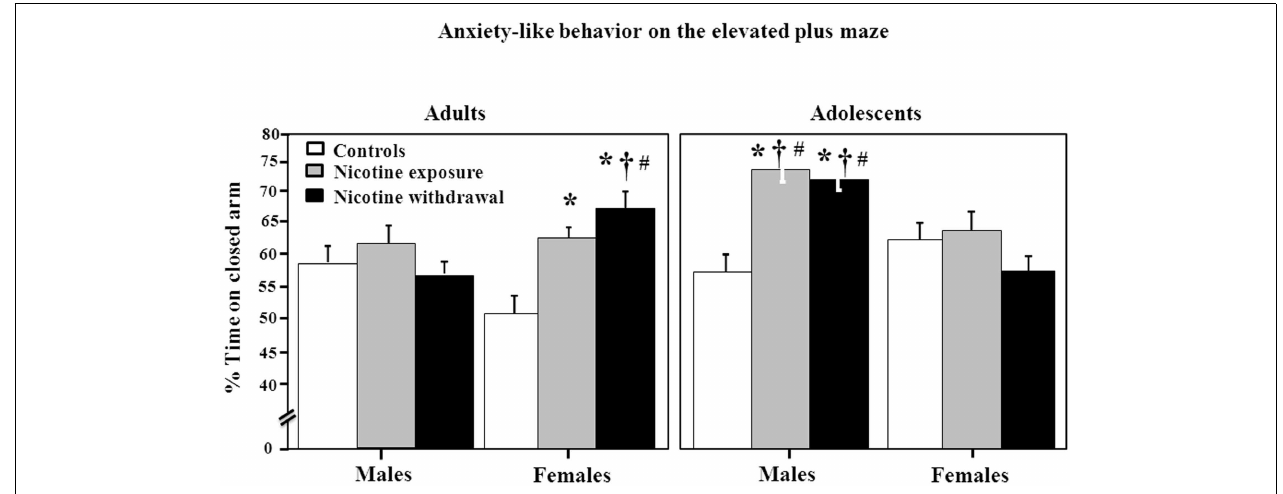
(control n = 6; nicotine exposure n = 5; nicotine withdrawal n = 5) rats .The asterisks (*) denote a significant difference between nicotine-treated rats and their respective controls, the daggers (†) denote a significant difference between males and females, and the number signs (#) denote a significant difference between adults and adolescents ( P < 0.05).